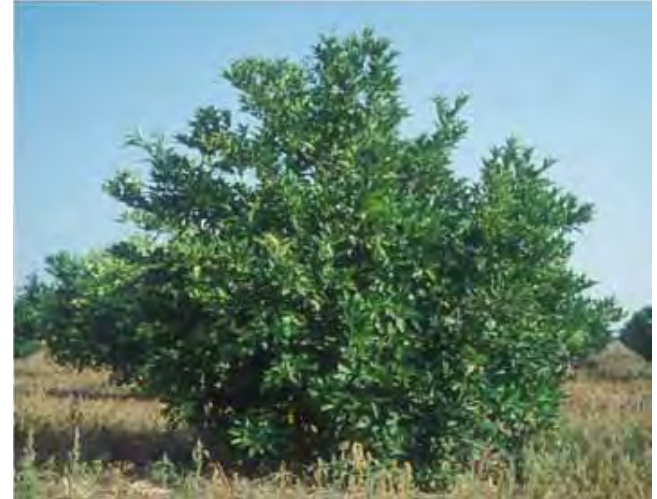
Fig. 6 - ‘Tarocco’ clone NL 57-E-1 orange tree.